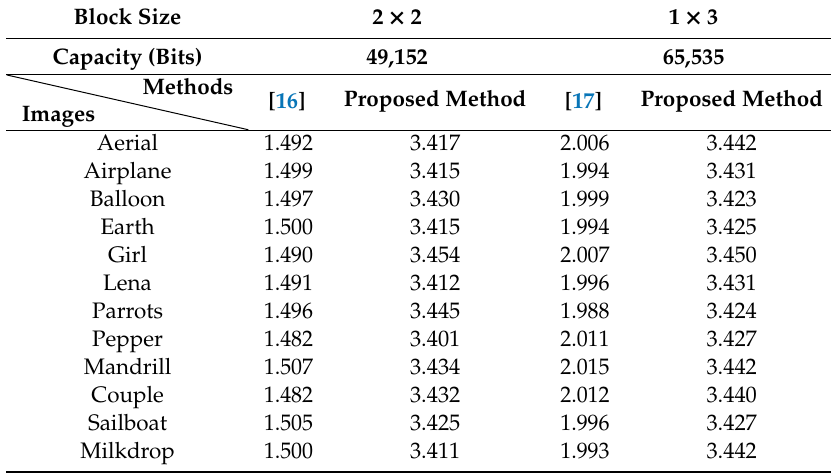
Table 9. Experimental embedding e ffi ciencies of Imaizumi et al.’s [16], Aryal et al.’s [17], and the proposed methods with k =